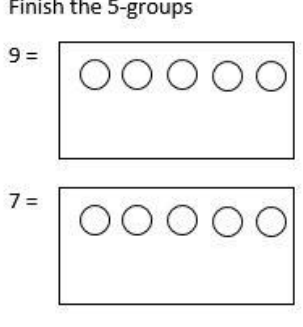
Figure 2 . Transfer worksheet for pre-test post-test, and delayed